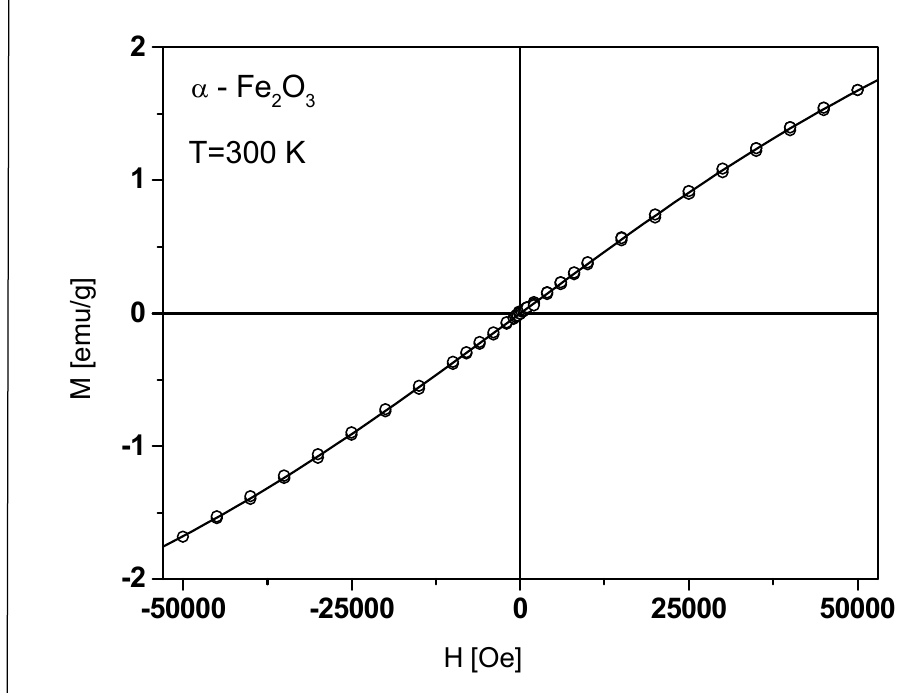
Figure 8 – Langevin function fit (full line) to the M ( H ) data (dots) measured at 300